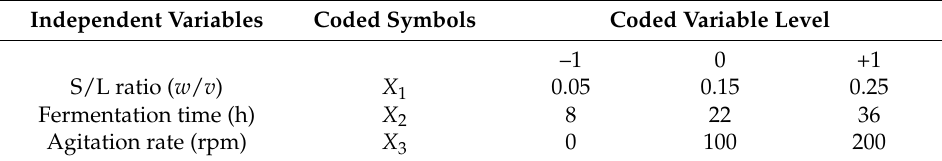
Table 1. Level and code of independent variables used for Box-Behnken experimental